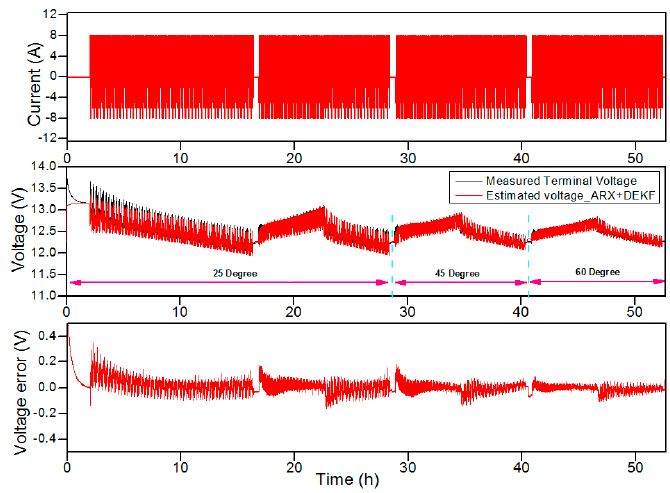
Figure 13. Current profile (upper graph), measured terminal voltage and temperature variation (middle graph) and estimated voltage error (lower graph).